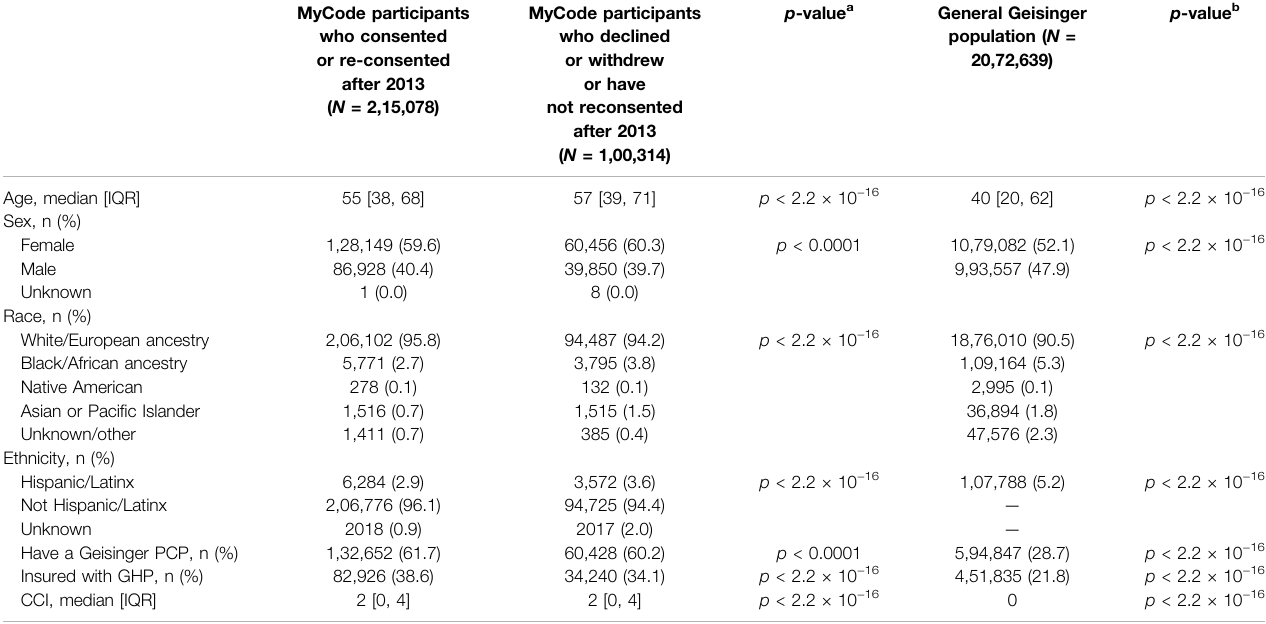
TABLE 3 | Characteristics of MyCode participants and general Geisinger